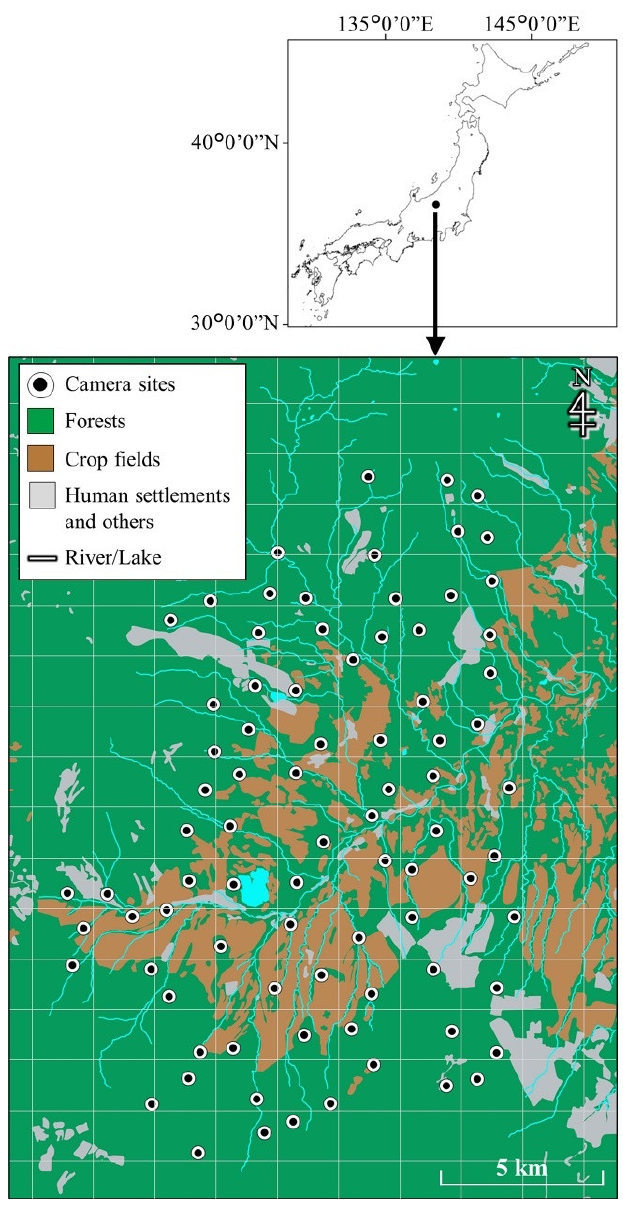
Figure 1. Study area in Tsumagoi, central Honshu, Japan. Camera traps were placed at 83 sites to monitor Japanese serows and sika deer between July and September 2012. The study area was divided into approximately 1.7 × 1.7 km grids. The map was created based on national land use information (Ministry of Land, Infrastructure, Transport and Tourism of Japan) and 6–7th Japanese National Survey of the Natural Environment (Ministry of the Environment of